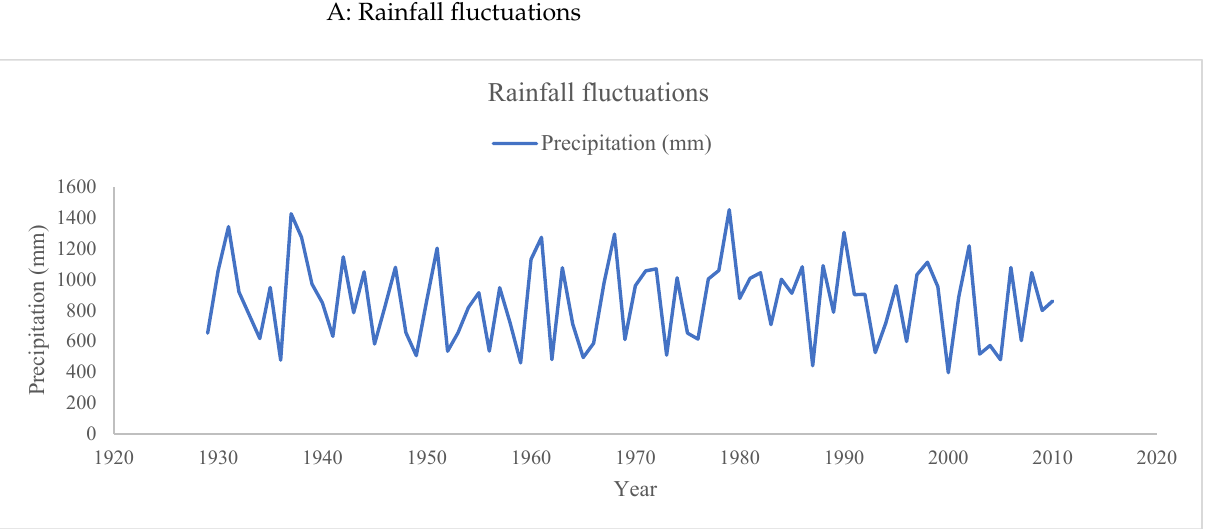
Figure A2. Temperature fluctuations—Changes in annual temperature (°C) measured at Moshi Airport Moshi Municipal, Kilimanjaro station No: 9337004 coordinates 3°21′0″ S and 37°19′48″ E. Appendix C CRS-standard approach With s  as the experimentally derived dry bulk density in section n , the cumulative dry mass m  above sediments at depth x  can be calculated as: m  = m  + s  (x  − x  )